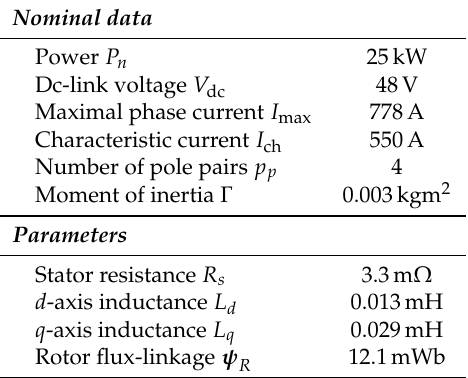
Table 1. Motor data.